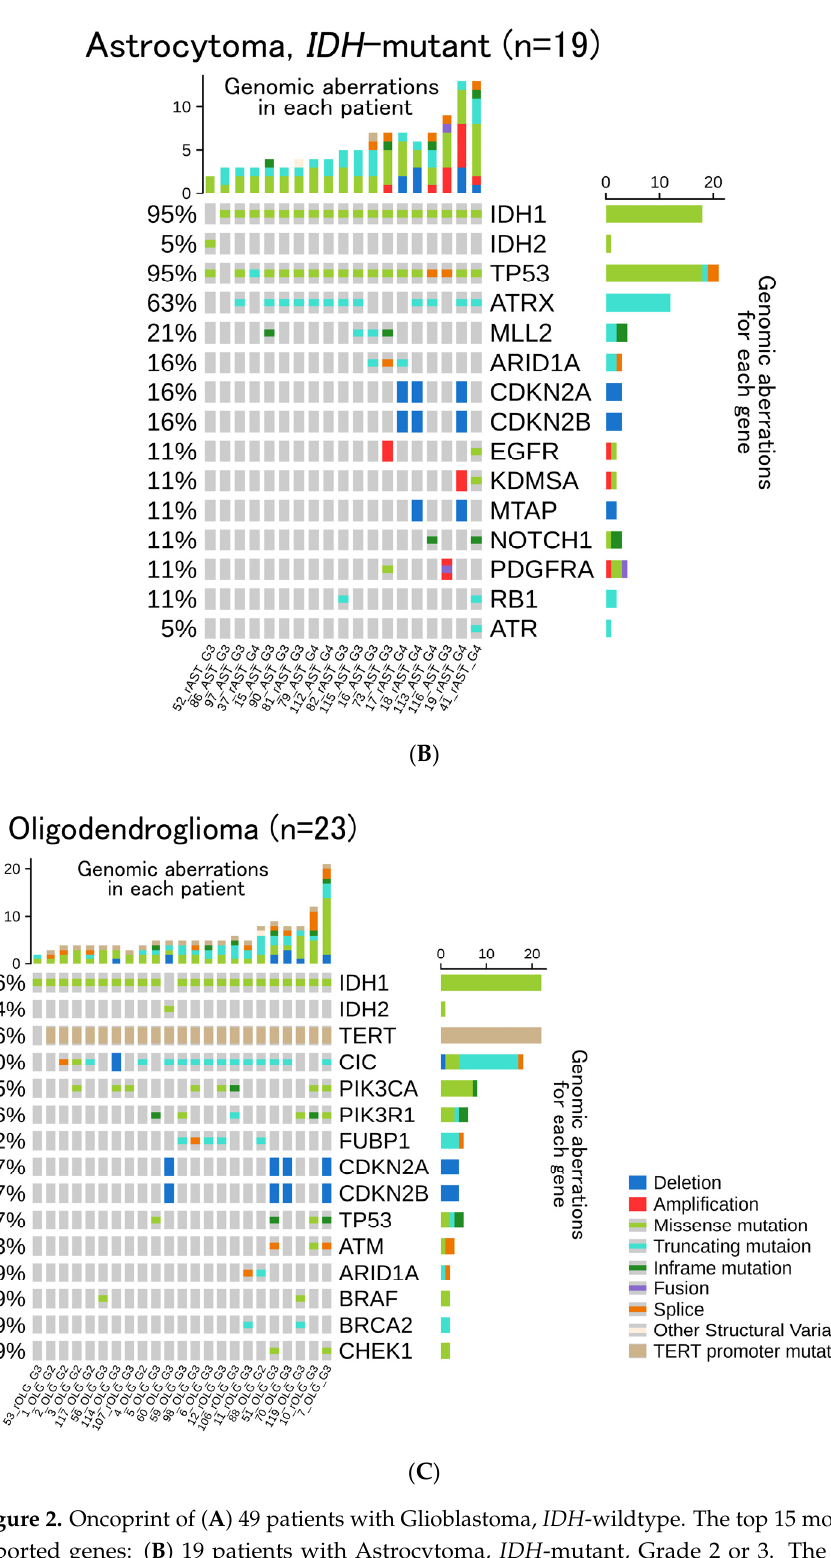
Figure 2. Oncoprint of ( A ) 49 patients with Glioblastoma, IDH ‐ wildtype. The top 15 most frequently reported genes: ( B ) 19 patients with Astrocytoma, IDH ‐ mutant, Grade 2 or 3. The top 15 most frequently reported genes; ( C ) 23 patients with Oligodendroglioma, IDH ‐ mutant, and 1p/19q ‐ co ‐ de ‐ leted, Grade 2 or 3. The top 15 most frequently reported genes are displayed respectively.